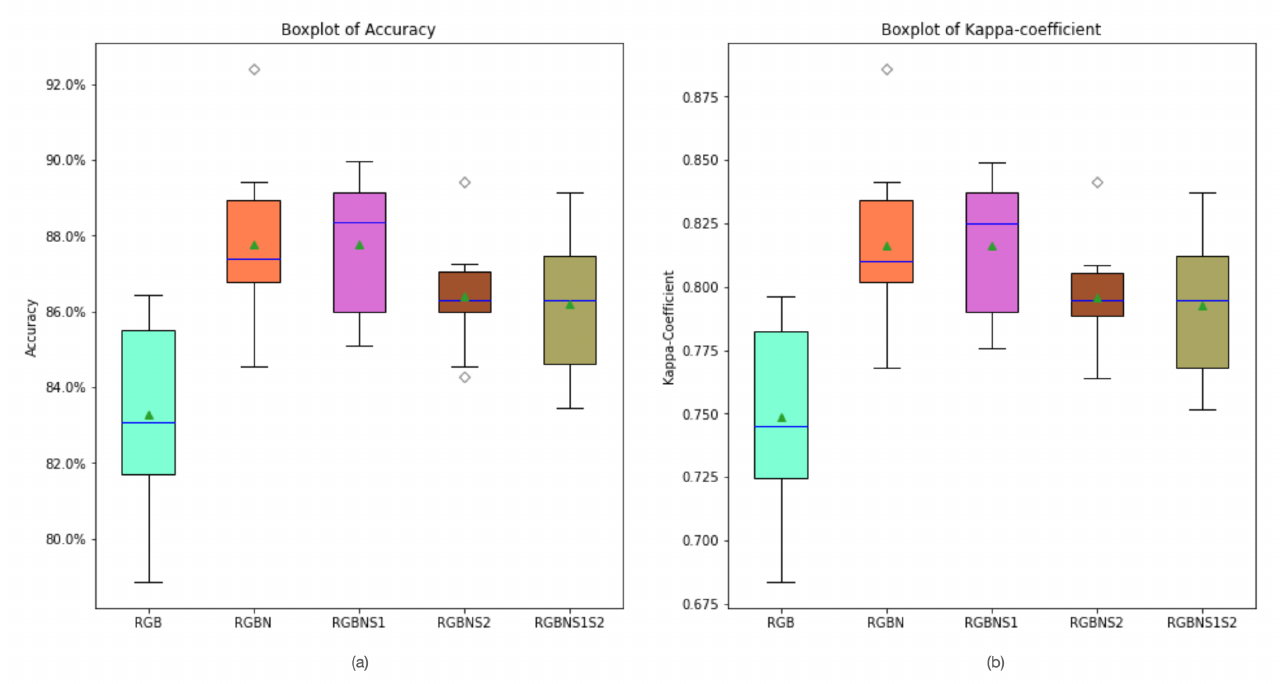
Figure 8. Boxplots based on the 10 results. ( a ) Accuracy. ( b ) Kappa-coefficient.